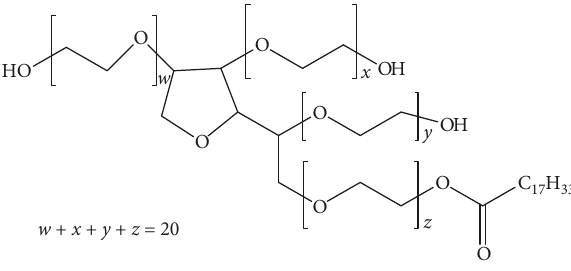
Figure 1: Chemical structural of